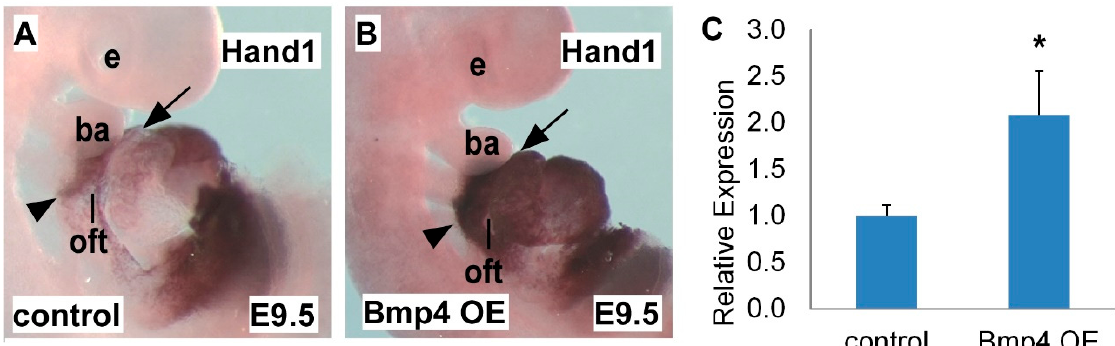
Figure 2. Hand1 is upregulated upon Bmp4 overexpression (OE). ( A , B ) Whole-mount in situ hybridization of E9.5 Bmp4 OE embryo compared with control embryo; Bmp4 OE embryos expanded Hand1 expression in the SHF and SHF-derived OFT and RV. ( C ) qRT-PCR indicated increased Hand1 expression level in Bmp4 OE embryos compared with control embryos. e, eye; ba, branchial arch; oft, outflow tract; rv, right ventricle. Arrows and arrow heads point out in situ hybridization signals in the OFT and SHF. Data are presented as means ± s.e.m. * indicates p -value < 0.05..